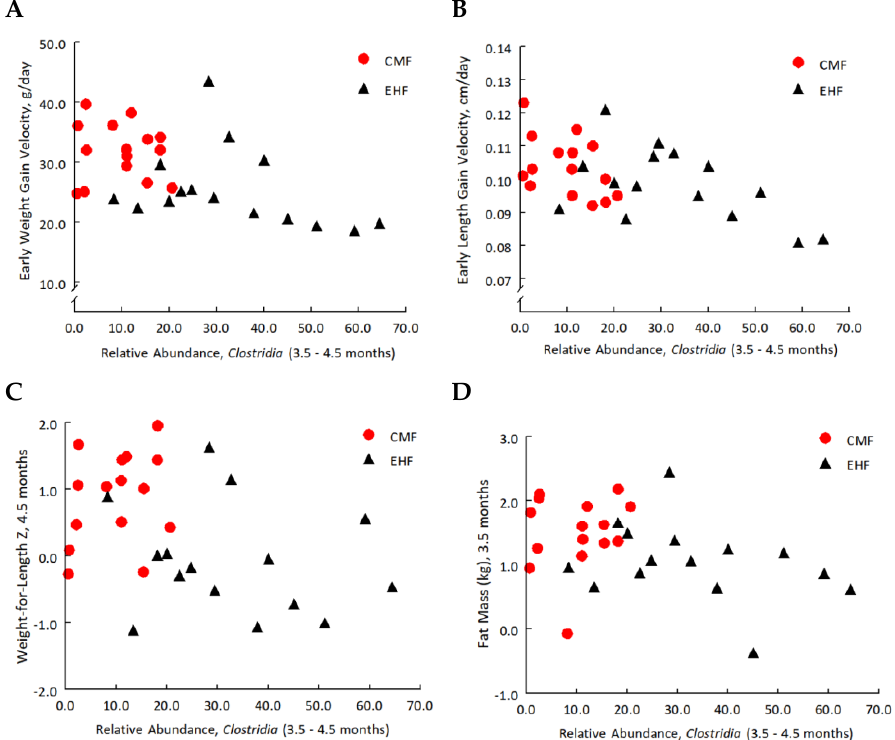
Figure 7. Pearson correlations between relative abundance of Clostridia (3–4 months) and ( A ) early weight gain velocity (g/day; p = 0.004), ( B ) early length gain velocity (cm/day; p = 0.003), ( C ) WLZ at 4.5 months ( p = 0.02), and ( D ) fat mass (kg) at 3.5 months ( p = 0.03). Red circles denote CMF (cow milk formula) and black triangles denote EHF (extensive protein hydrolysate) groups.